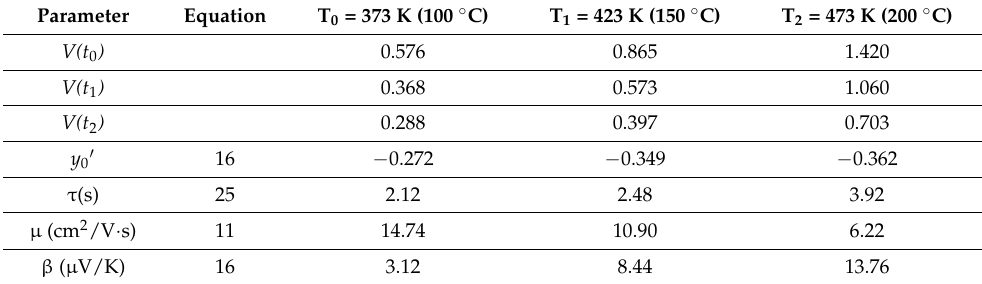
Table 2. Measured voltage and basic calculated parameters of the ITO film. Parameter